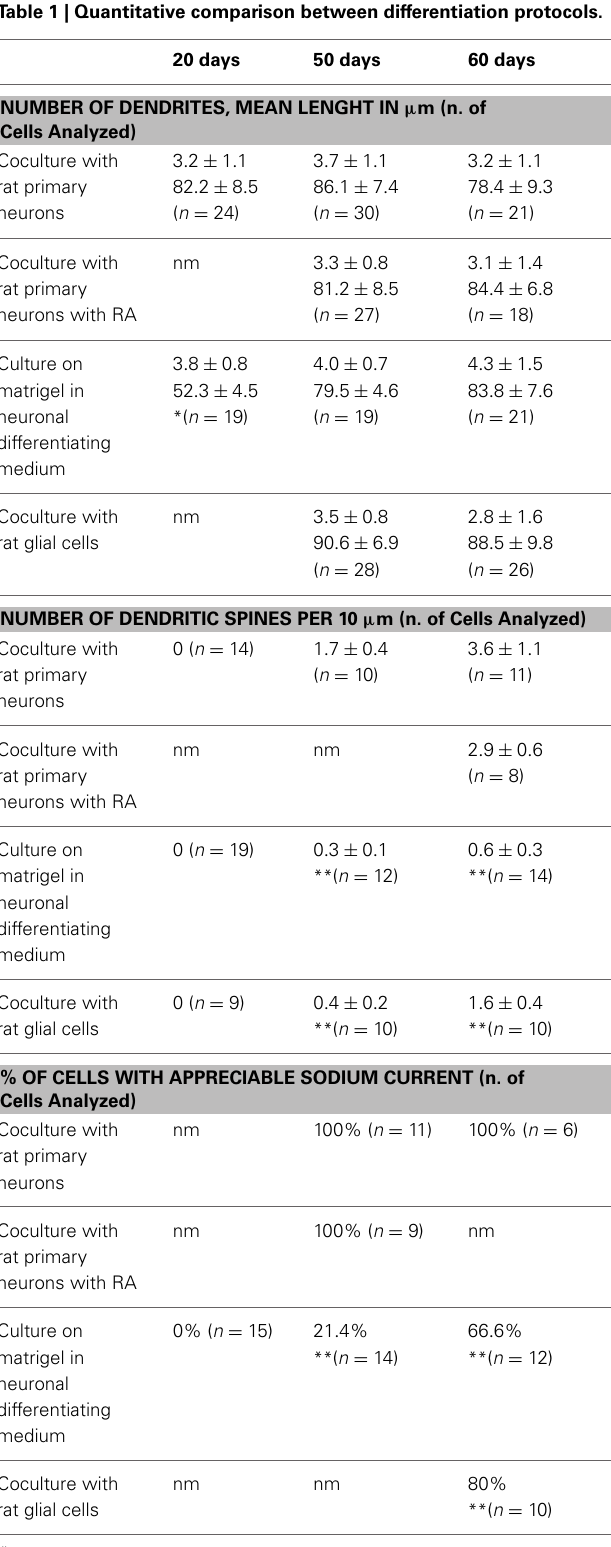
Table 1 | Quantitative comparison between differentiation protocols.